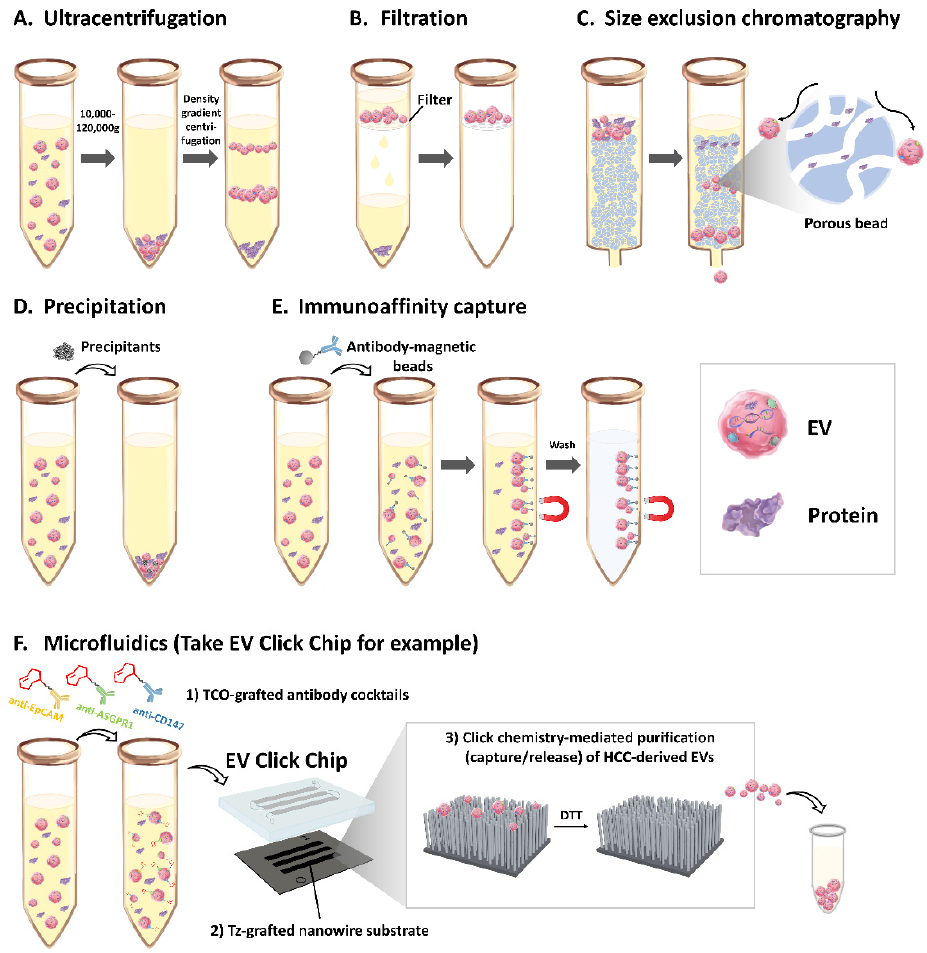
Figure 1. Schematic summary of the EVs isolation methods. ( A ) Ultracentrifugation. By centrifugation at the speeds of 10,000–20,000 g and 100,000–120,000 g, large and small EVs are separated, respectively. Density gradient ultracentrifugation can be used for further EVs purification. ( B ) Filtration. Using a series of membrane filters with different pore diameters enables isolation of EVs with a specified size. ( C ) Size exclusion chromatography. The chromatography column consists of porous beads only allowing smaller particles, such as proteins, to enter. EVs are larger than the pore size; therefore, they migrate at a higher speed than the smaller particles and are isolated. ( D ) Precipitation. Precipitants occupy the solution and make less soluble particles, including EVs, exceed their solubility limit and precipitate. ( E ) Immunoaffinity capture. Antibodies targeting surface proteins on EVs are used to positively or negatively select specific subpopulations of EVs. ( F ) Microfluidics. For example, EV Click Chip: (1) the multimarker antibody cocktails enable targeting HCC-derived EVs, (2) nanostructured substrates increase the surface interacting with EVs, and (3) click chemistry-mediated EVs capture (TCO/TZ interaction) and disulfide cleavage lead to DTT-driven EVs release, which results in isolation of HCC-derived EVs with high purity. ASGPR1, asialoglycoprotein receptor 1; DTT, 1,4-dithiothreitol; EpCAM, epithelial cell adhesion molecule; EVs, extracellular vesicles; HCC, hepatocellular carcinoma; TCO, trans-cyclooctene; Tz,